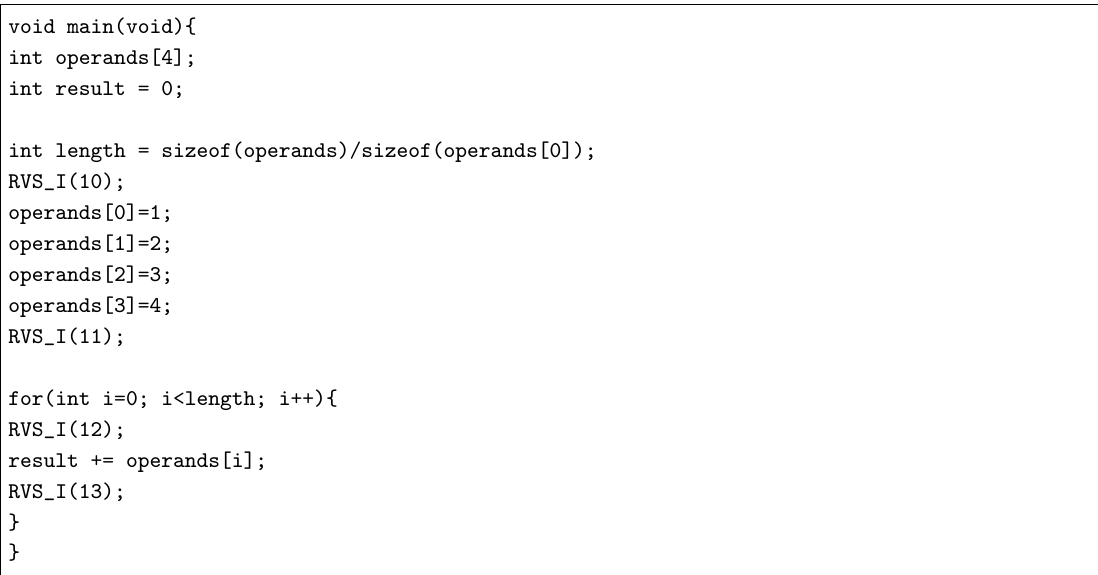
Code 1: Walkthrough example C